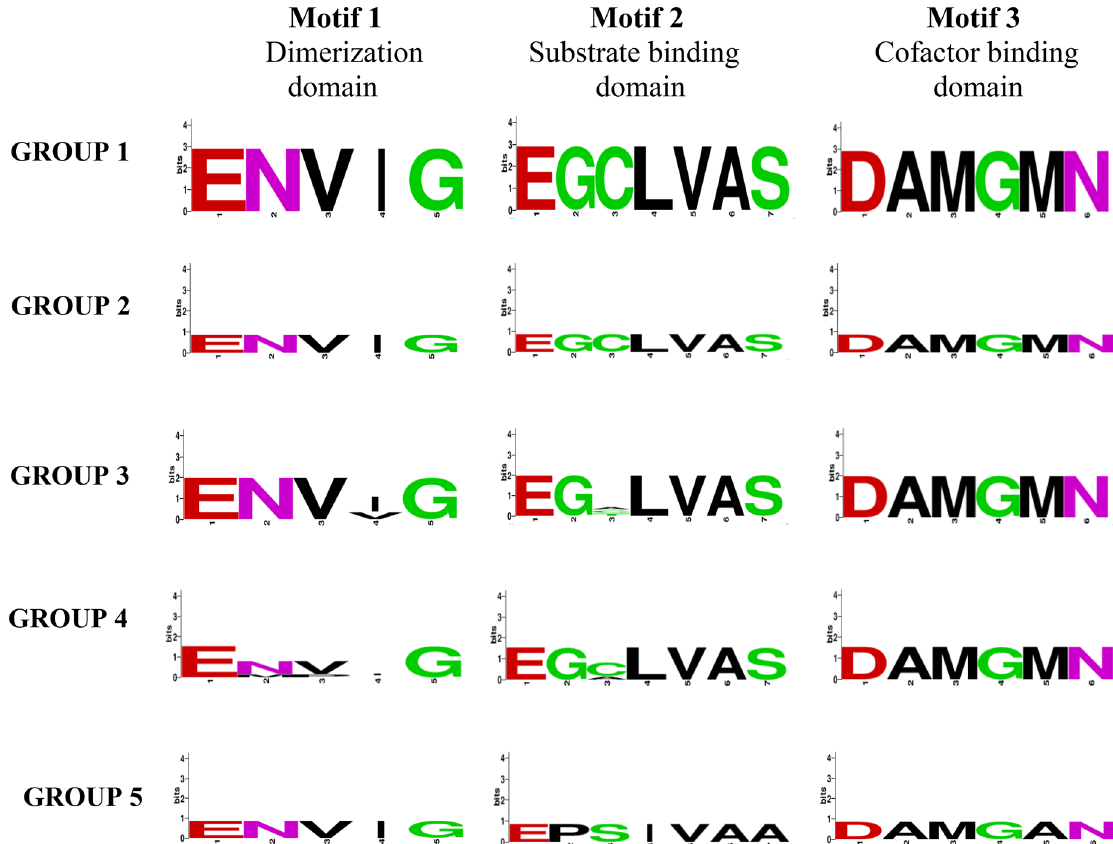
Figure 1. Sequence logos of the conserved motifs found in the catalytic domain of the HMGRs of different organisms. Multiple alignments were performed with Clustal Omega and the consensus logos were generated with WebLogo. Group 1 ( Candida auris , Candida haemulonii , Clavispora lusitaniae ATCCC 42720, Debaryomyces hansenii CBS767, Meyerozyma guilliermondii ATCC 6260, Candida parapsilosis , Candida orthopsilosis Co 90-125, Candida tropicalis MYA-3404, Candida albicans SC5314, and Candida dubliniensis CD36); group 2 ( C. glabrata CBS138, Candida kefyr , Kluyveromyces lactis NRRL Y-1140, Saccharomyces cerevisiae S288c HMG1, and S. cerevisiae S288c HMG2); group 3 ( Yarrowia lipolytica CLIB122, S. pombe , and Ustilago maydis ); group 4 ( Drosophila melanogaster , Mus musculus , H. sapiens , and Rattus norvegicus ); and group 5 ( P. mevalonii